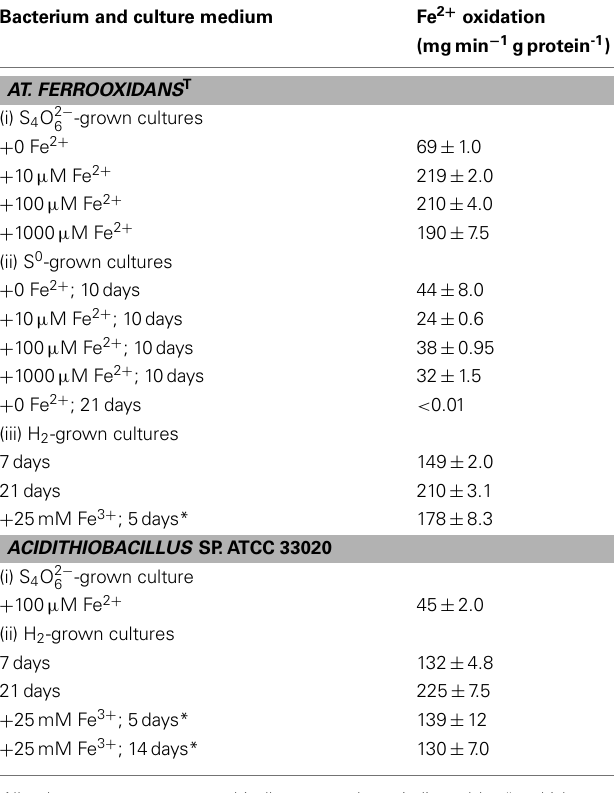
Table 4 | Effects of different electron donors and culture conditions on the specific rates of ferrous iron oxidation by Acidithiobacillus